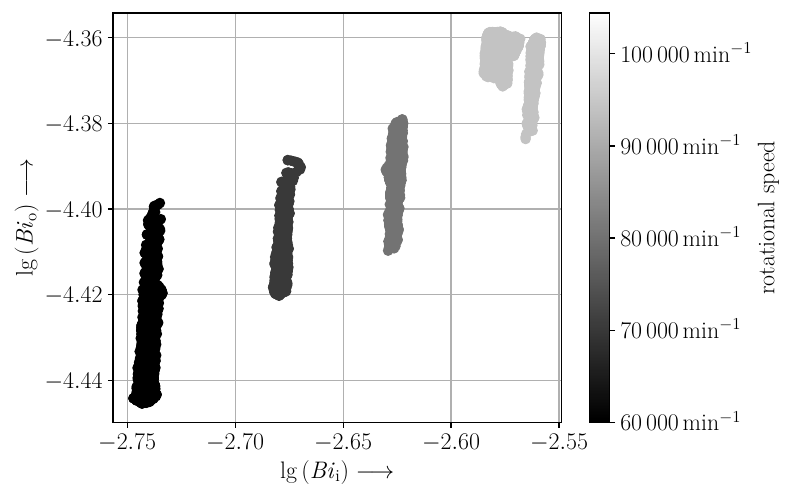
Figure 11. Scatter plot of experimentally-identified Biot numbers in the